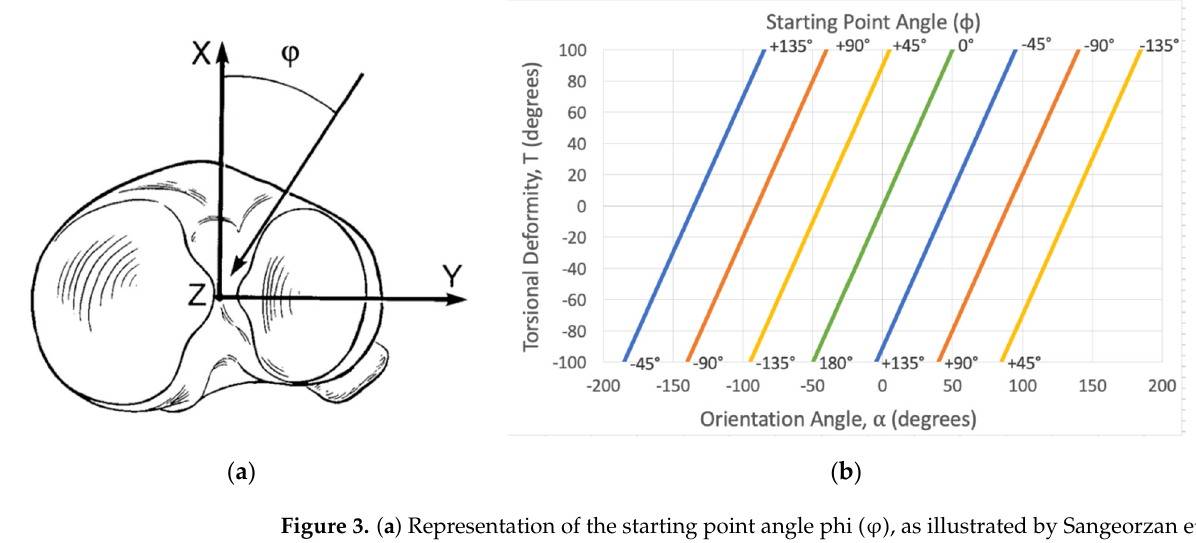
Figure 3. ( a ) Representation of the starting point angle phi ( φ ), as illustrated by Sangeorzan et al. [1]. It describes how far to rotate the osteotomy plane based on the axial plane. It is referenced from the midline of the long axis. By convention, it is reported as a number less than 180°. A positive number rotates the osteotomy plane laterally and a negative number rotates it medially. ( b ) Corresponding graph that calculates φ based on the orientation angle ( α ) and the rotational deformity T. For the purposes of the graphical calculations, the relative internal rotational deformity is positive (+) and the relative external rotational deformity is negative ( − ) [1].